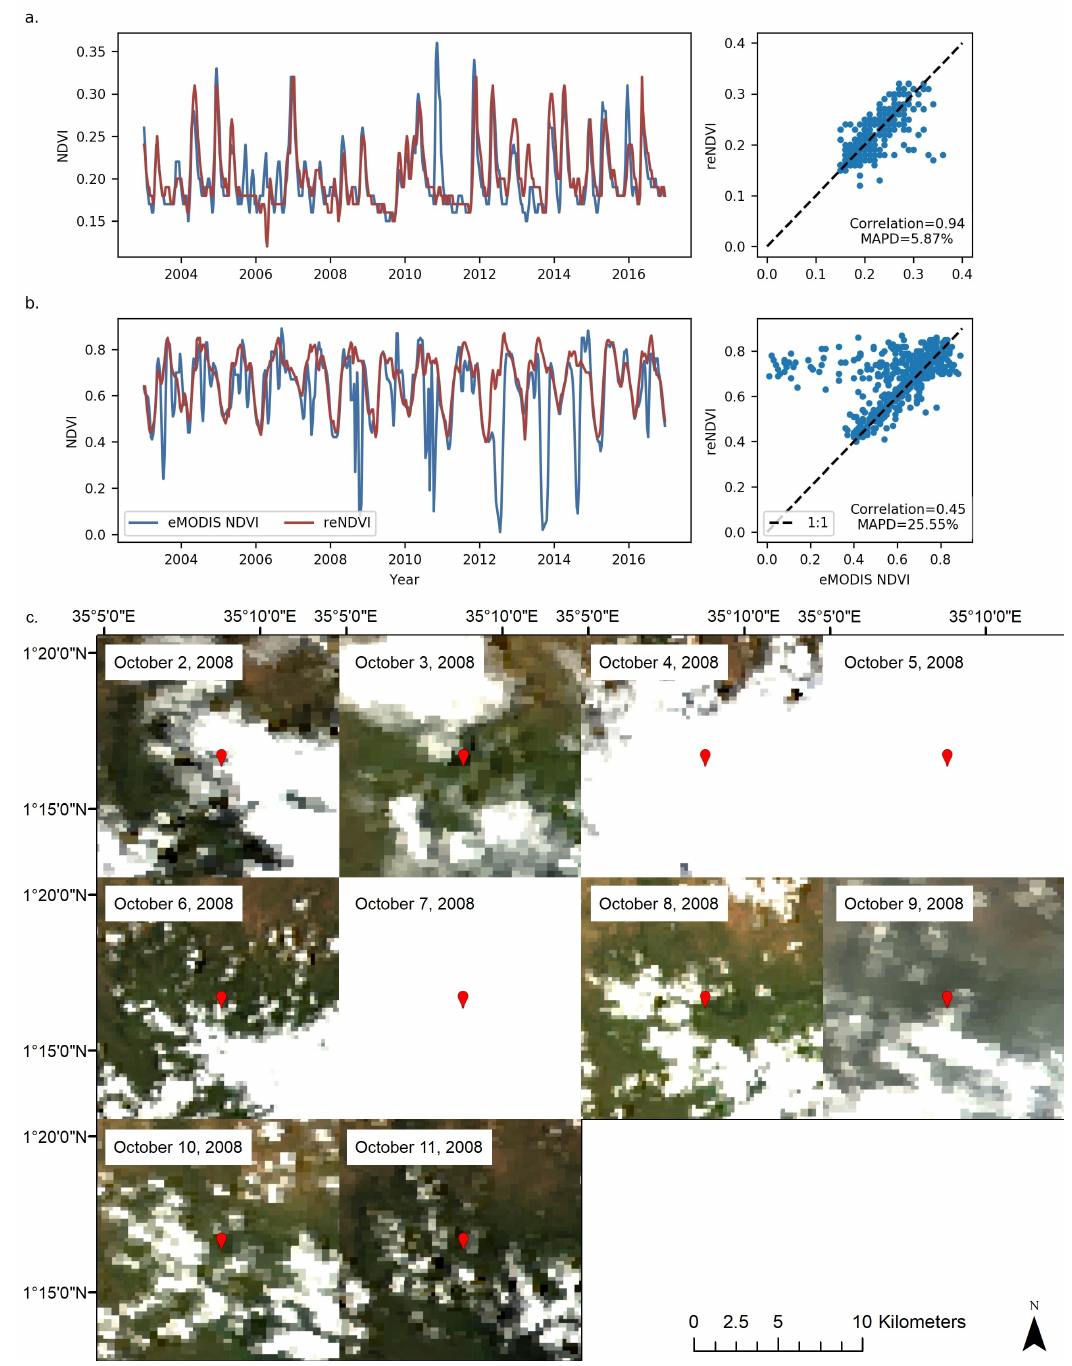
Figure 5. Time series and scatterplot at two locations with ( a ) high agreement [37.567, 1.946] and ( b ) low agreement [35.1467, 1.2657]. ( c ) shows that the dip in eMODIS NDVI was due to the influence of persistent cloud cover at one point on the time series shown in ( b